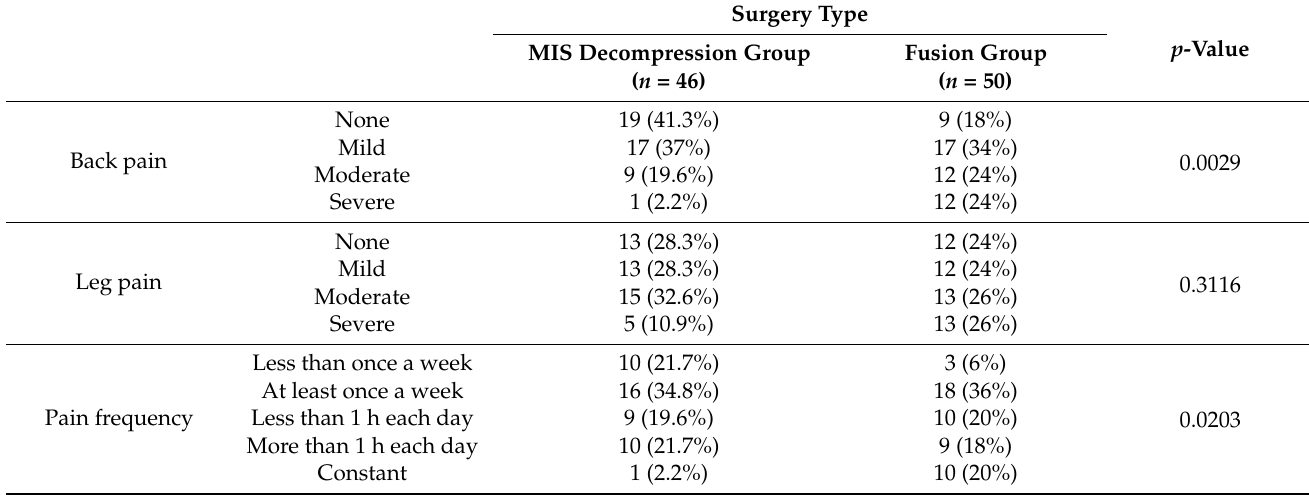
Table 2. Back and leg pain intensity and frequency in both